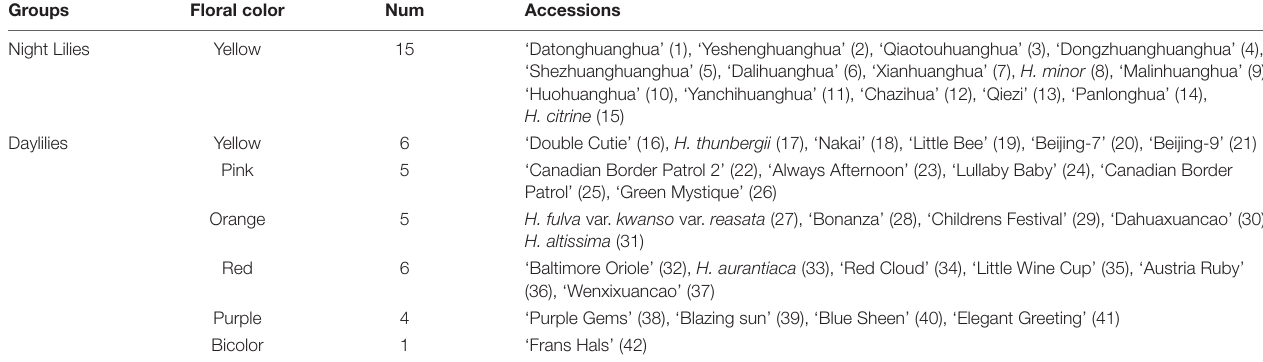
and anthocyanins in different Hemerocallis germplasm